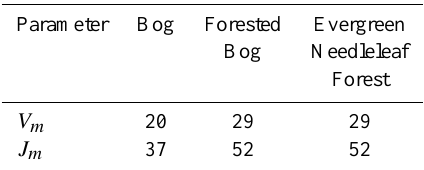
Table 1. Photosynthesis parameters for land cover classes in this study. Units are µmolCO 2 m − 2 s − 1